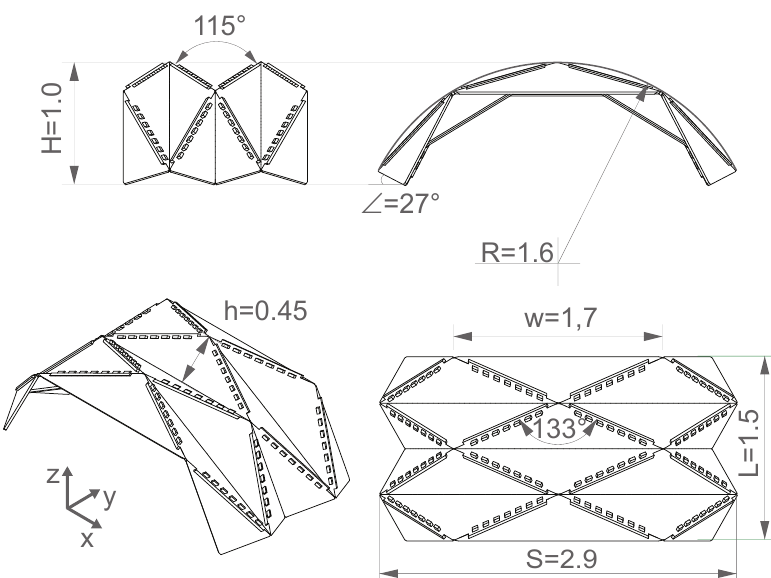
Figure 1. Large scale structure geometry parameters.